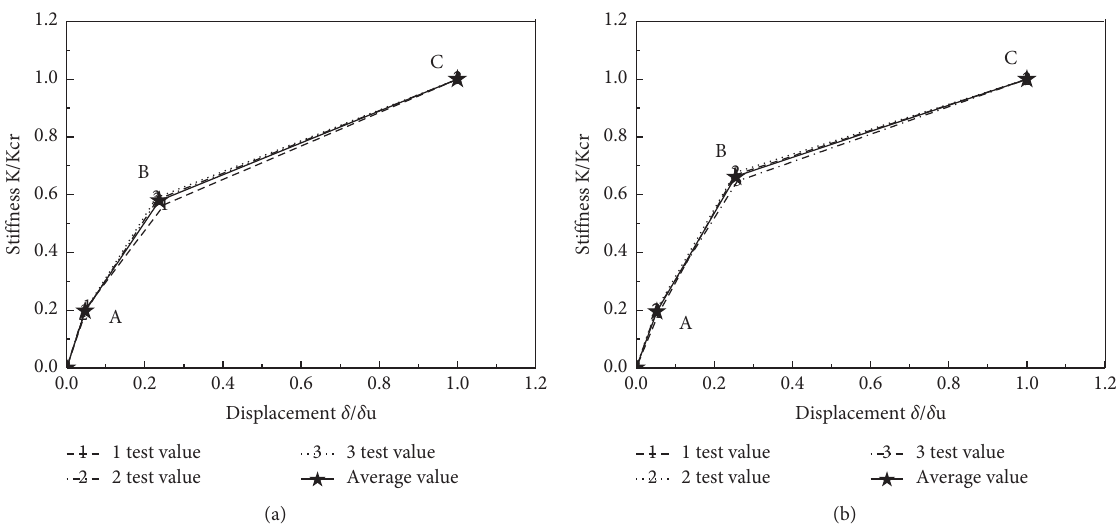
Figure 11: Nondimensional stiffness-displacement relation. (a) Conventional composite plate. (b) Composite plate considering thermal insulation